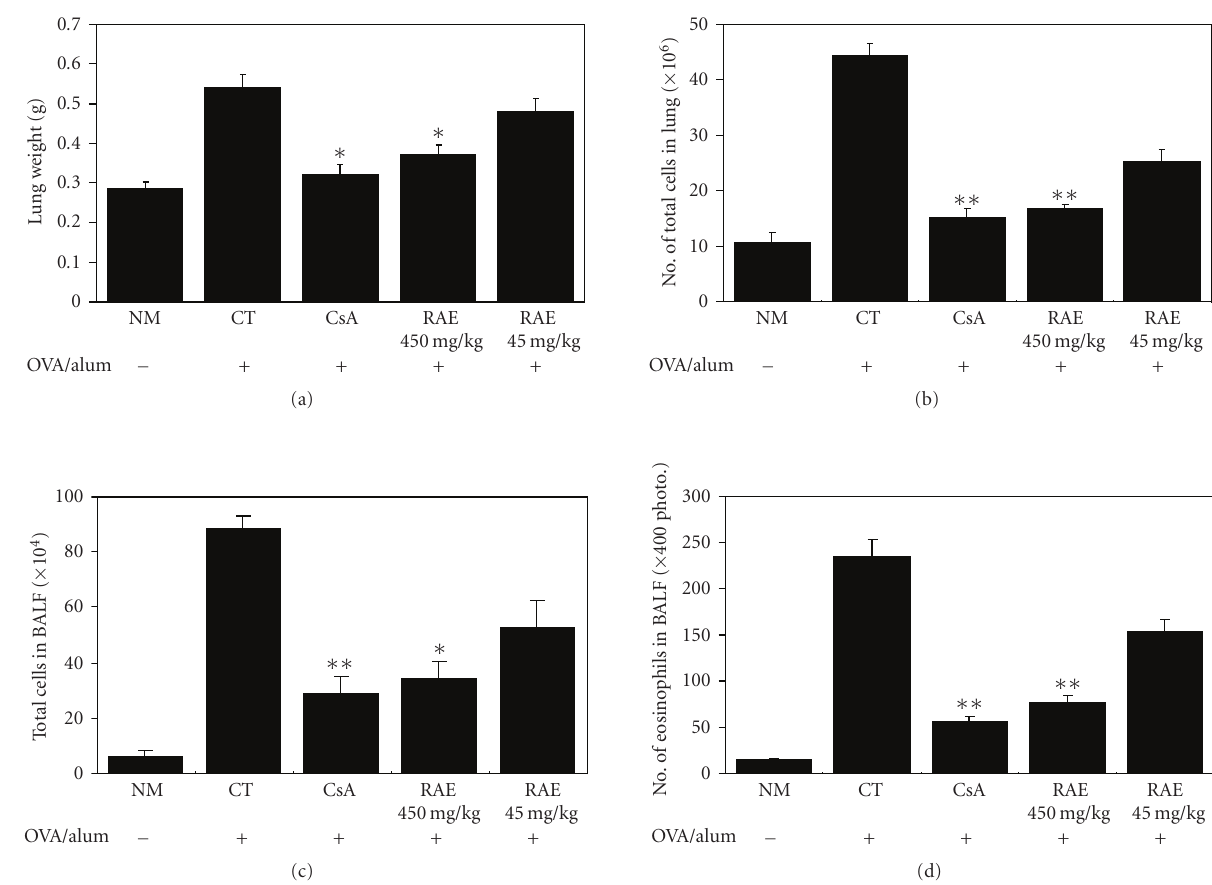
Figure 4: E ff ects of RAE on lung weights and total lung cells in OVA-induced asthma murine (NM: normal C57BL/6 mice; CT: OVA-induced asthma mice (control); CsA: OVA-induced asthma mice treated with cyclosporine A (10mg/kg); RAE 450mg/kg: OVA-induced asthma mice treated with RAE (450mg/kg); RAE 45mg/kg: OVA-induced asthma mice treated with RAE